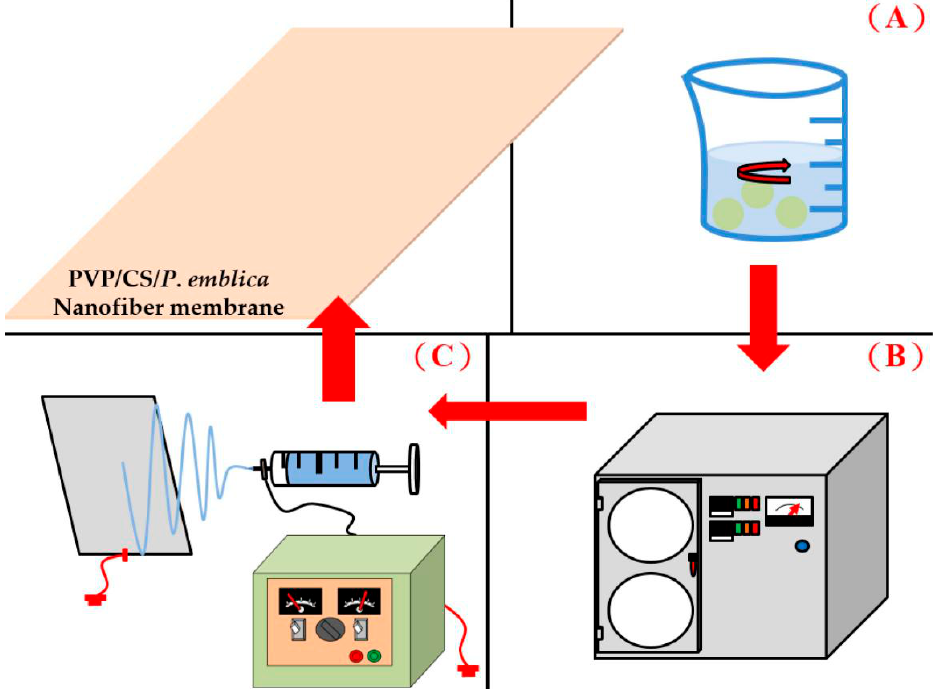
Figure 1. The manufacturing process of dry facial masks composed of nanofiber membranes: ( A ) the extraction process, ( B ) freeze-drying process, and ( C ) the preparation process of nanofiber mem- branes.